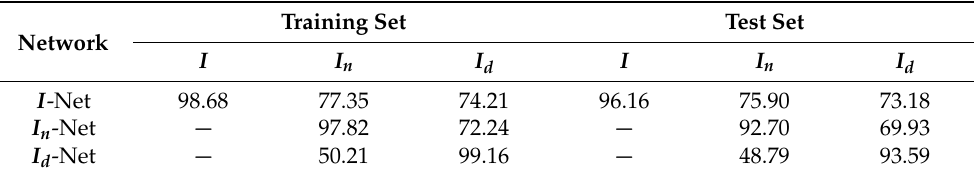
Table 3. Accuracies of the trained CNNs for different datasets including training and test sets. Training Set Test Network